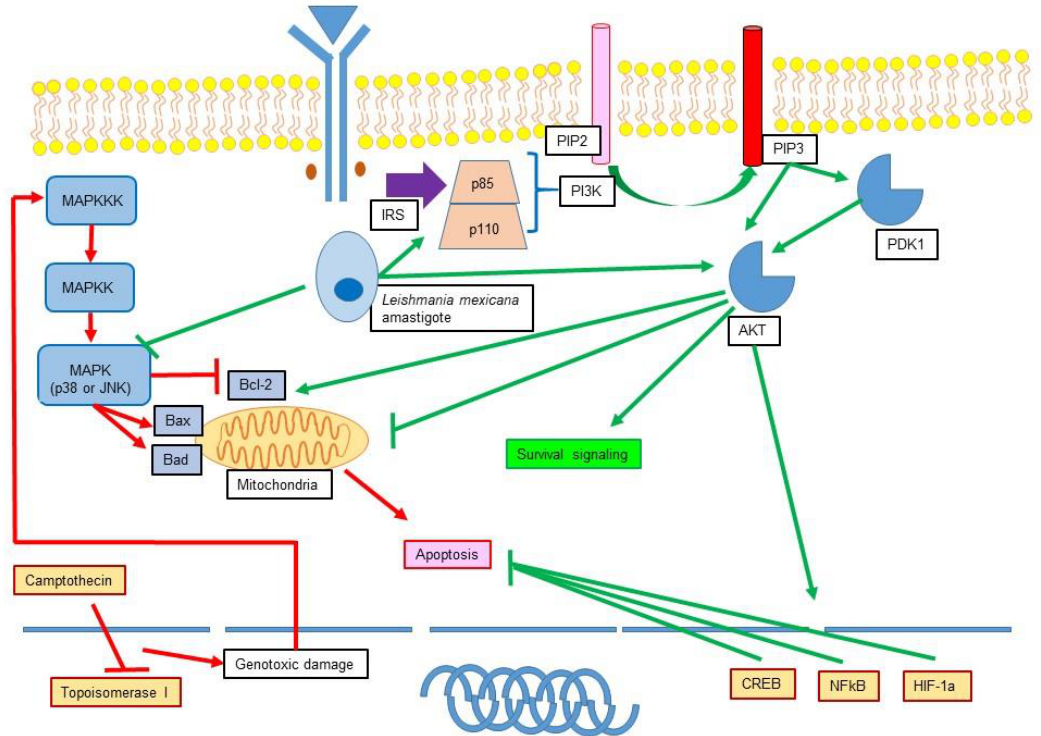
Figure 3. Apoptosis inhibition in Leishmania mexicana . Schematic representation of the proposed apoptosis inhibition mechanisms of L. mexicana amastigotes in human monocyte-derived dendritic cells (moDC) by Vázquez-López and colleagues. In this model, L. mexicana inhibits apoptosis even when dendritic cells have received a known apoptogenic stimulus (camptothecin). The parasite inhibits mitogen-activated protein kinase (MAPK), Jun N-terminal kinase (JNK) and p38 phosphorilation (proapoptotic mechanisms) and activates phosphatidylinositol 3-kinase (PI3K)/Akt (antiapoptotic mechanisms). IRS: insulin receptor substrate; PIP 2 : phosphatidylinositol 4,5-